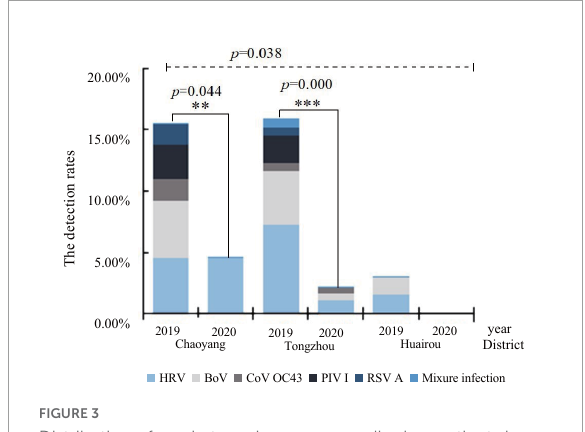
FIGURE3 Distribution of respiratory viruses among diarrhea patients in enteric disease clinics in Beijing from 2019 to 2020.